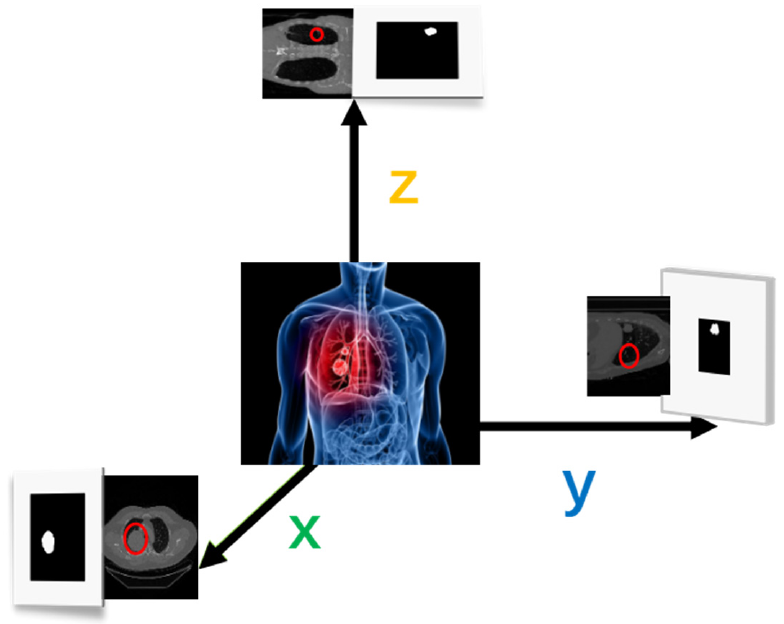
Figure 3. The section of lung nodule from three directions (the areas marked by red circles are where the lung nodules are located).